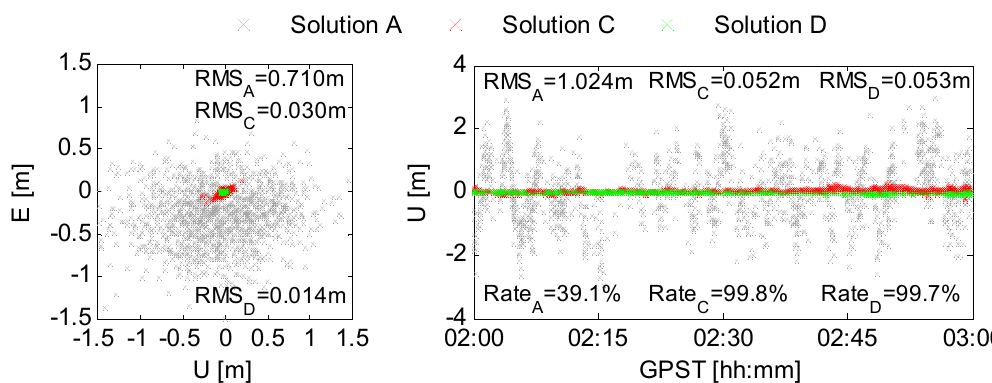
Figure 12. Single-epoch PPP ambiguity-fixed results at NCGO with GPS/Galileo dual-frequency data.